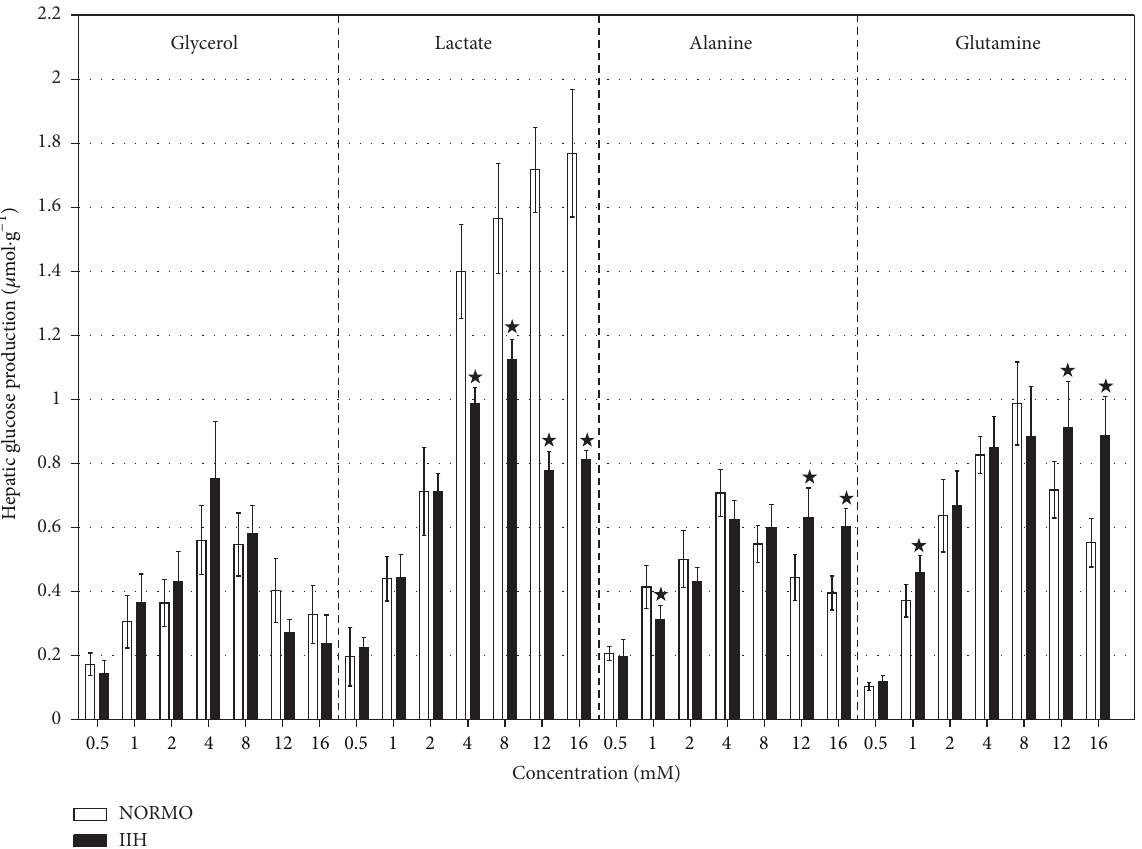
Figure 4: Hepatic production of glucose as a function of increasing concentrations of glycerol, lactate, alanine, and glutamine in 14hr fasted mice. The animals were subjected to in situ liver perfusion 180min after an intraperitoneal injection of regular insulin (1.0U ⋅ kg −1 , IIH group) or saline (NORMO group). The bars express the values of the area under curve ( 𝜇 mol ⋅ g −1 ), that is, (the increment of glucose production between 10 and 110min) as mean ± standard deviation of 6–8 experiments. 󳀅 𝑃 < 0.05 IIH versus